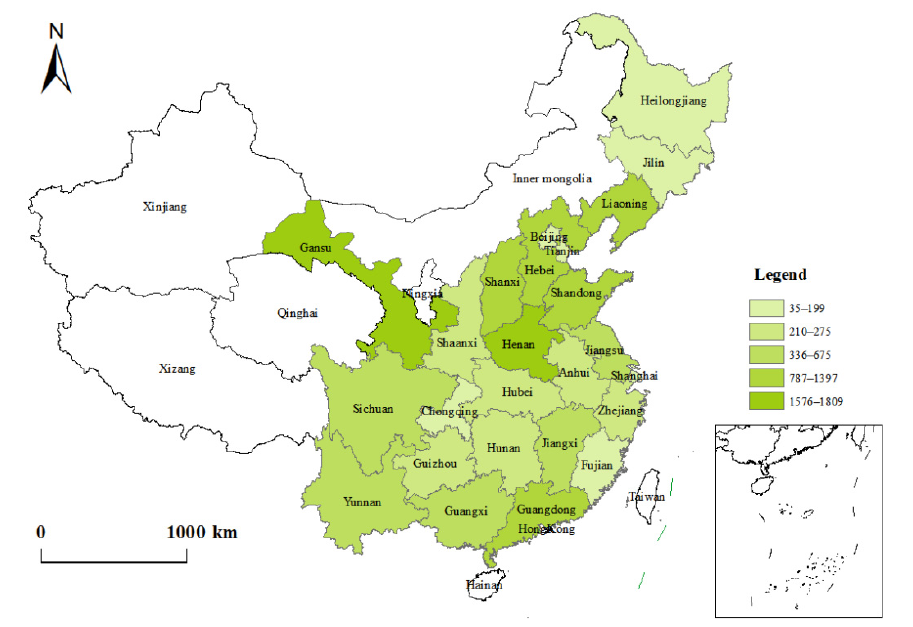
Figure 1. Sample distribution. Table 3. Socio-demographic statistics.